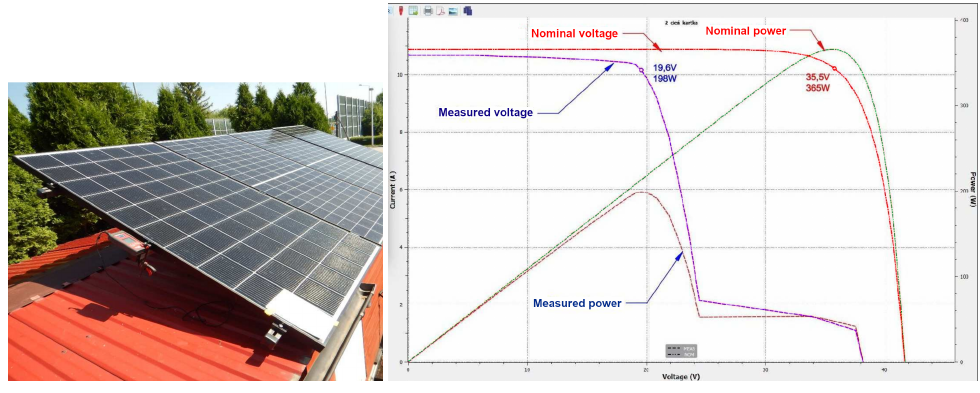
Figure 4. Shading with a piece of paper of a single cell in a controlled PV module ( left , next to the module, the Benning SUN2 attachment is visible) and the I–V curve of the whole module ( right inset ).